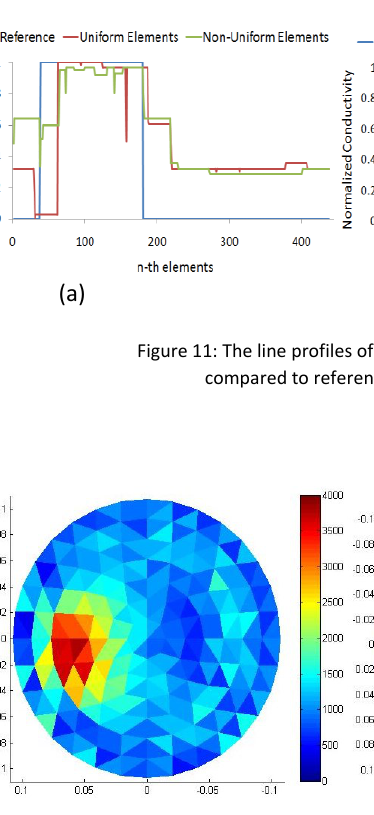
Figure 12: Reconstruction image of the Newton-Raphson method in uniform elements model